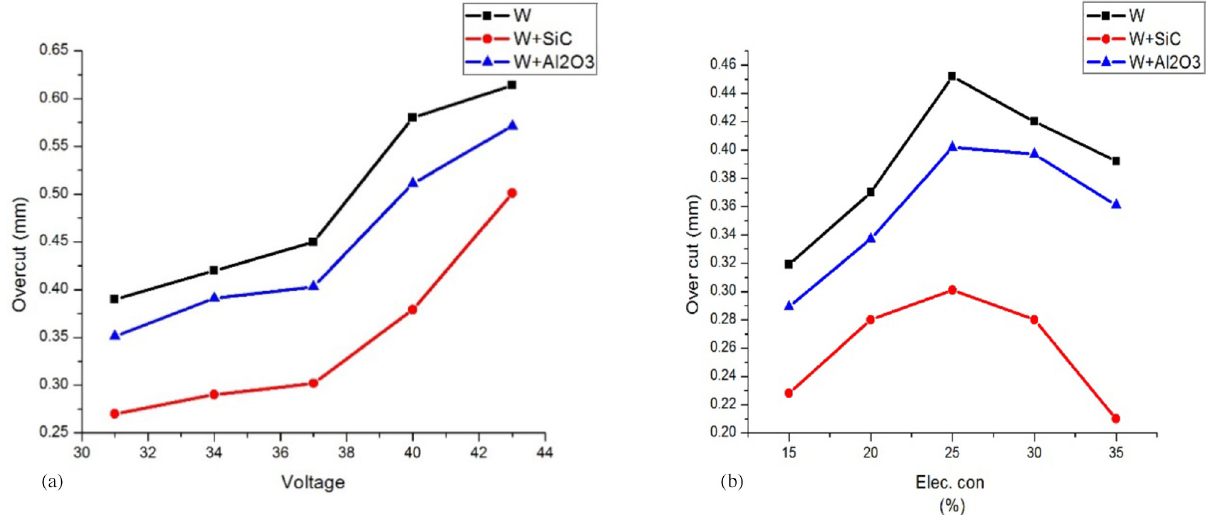
Fig. 4. (a) Effect of voltage on the outer diameter. (b) Effect of electrolyte conc. on the outer